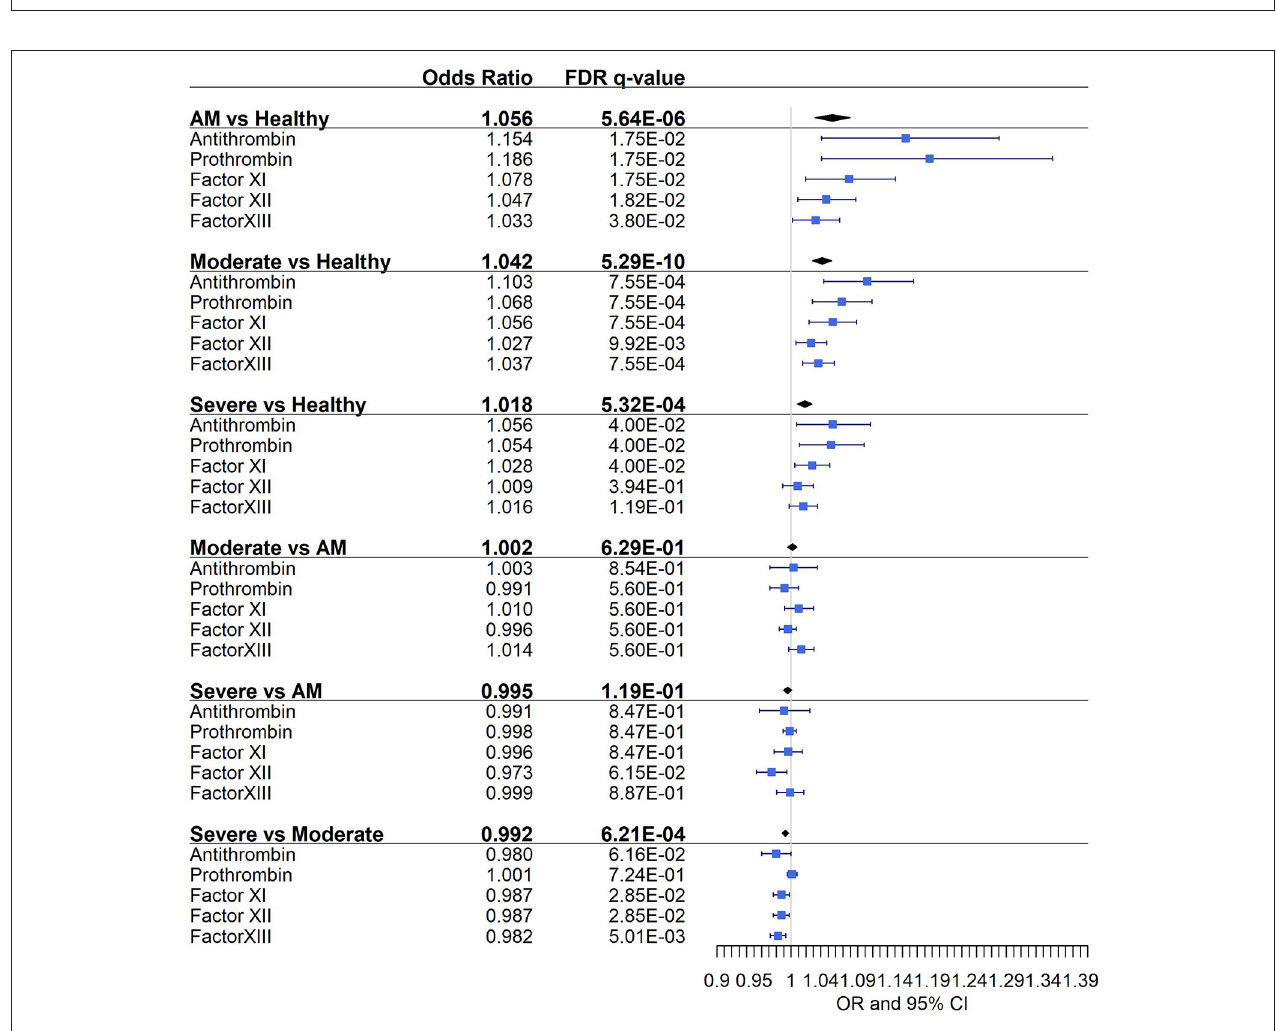
FIGURE 2 | (B) Kaplan-Meier plot. The cutoffs of coagulation proteins for the Kaplan-Meier plot were obtained using three quantiles to get low (blue), medium (yellow), and high (pink) percentages of the reference plasma. The specific categorical levels by using tertiles were as follows: Antithrombin: low (12.14–41.3), medium (41.3–54.1), high (54.1–136.7). Prothrombin: low (16.3–48.7), medium (48.7–72.2), high (72.2–545). Factor XI: low (10.8–56.4), medium (56.4–90.1), high (90.1–200.9). Factor XII: low (11.7–47.8), medium (47.8–87.1), high (87.1–301.9). Factor XIII: low (8.3–82.6), medium (82.6–118.3), high (118.3–242.7). AM, asymptomatic/mild patients; OLR, ordinal logistic regression.